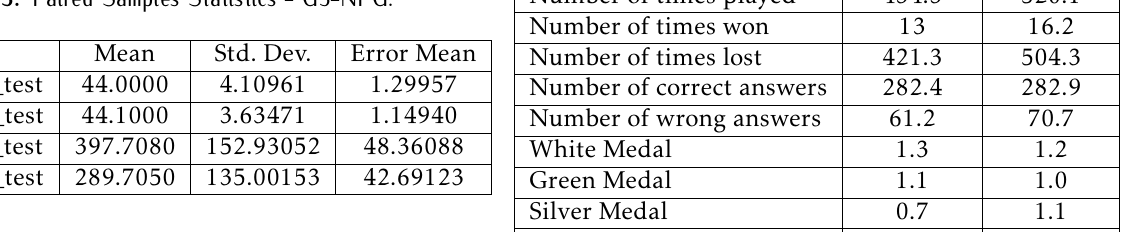
Table 3. Paired Samples Statistics - G3-NPG.